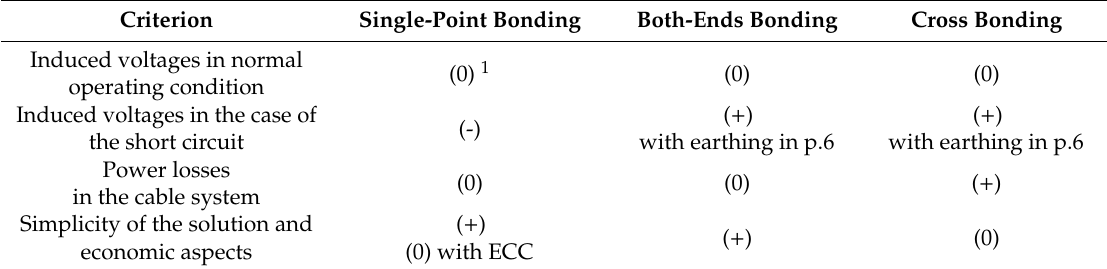
Table 1. A summary of the properties of the bonding systems in the analyzed cable line. Criterion